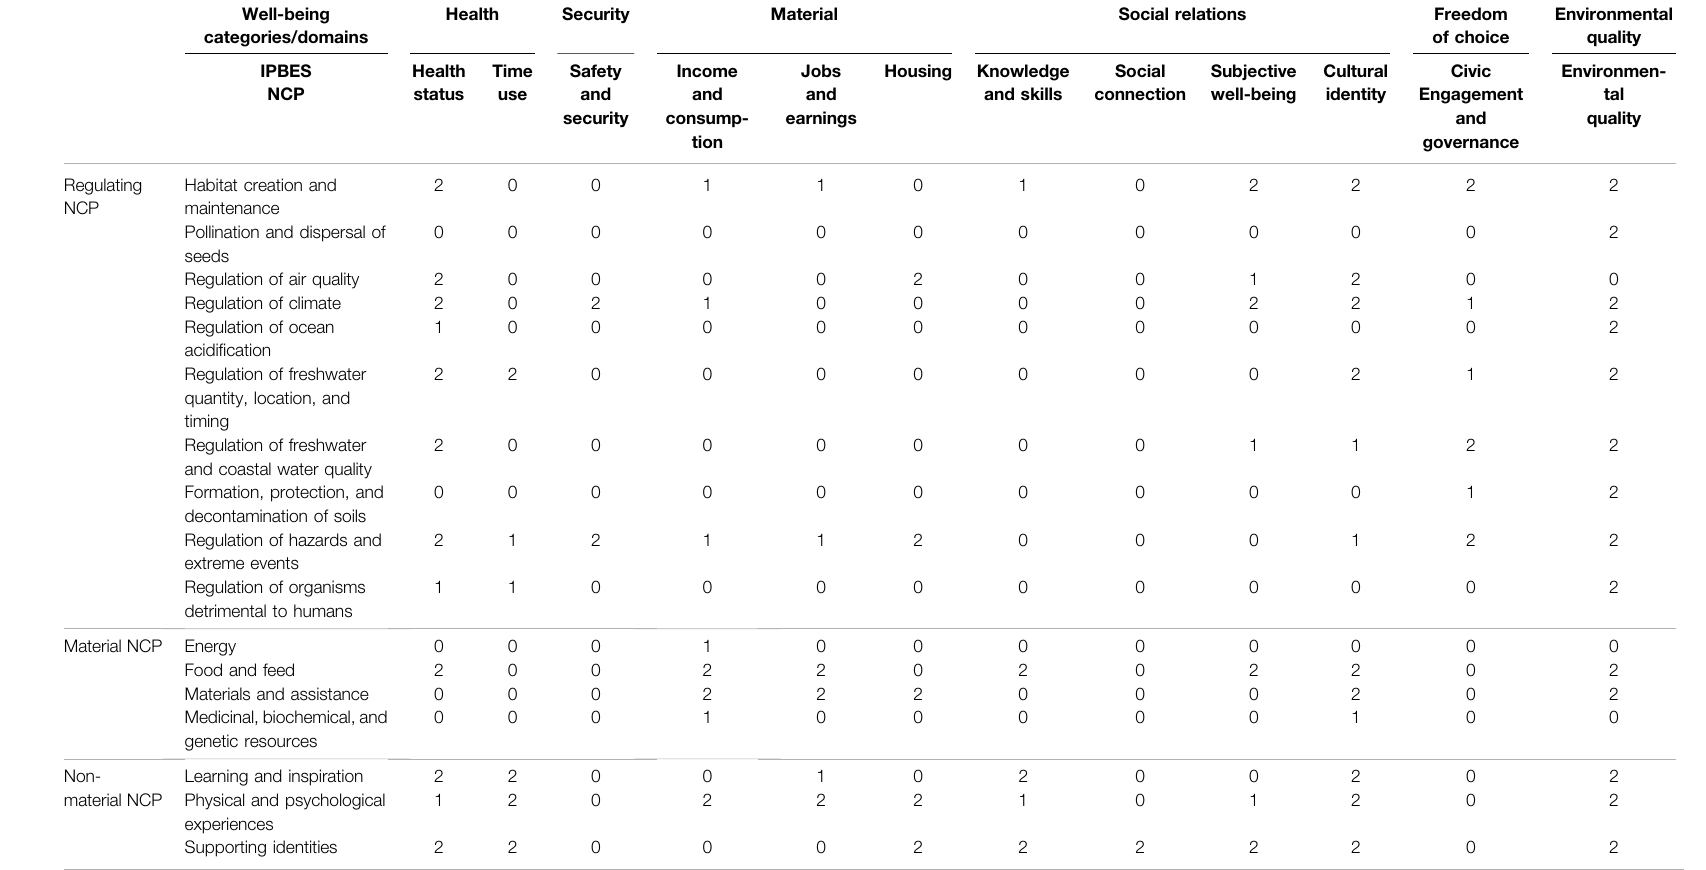
TABLE 4 | Final prioritizations scores of 17 NCP against the 12 LSF well-being domains and their six broad categories. Well-being